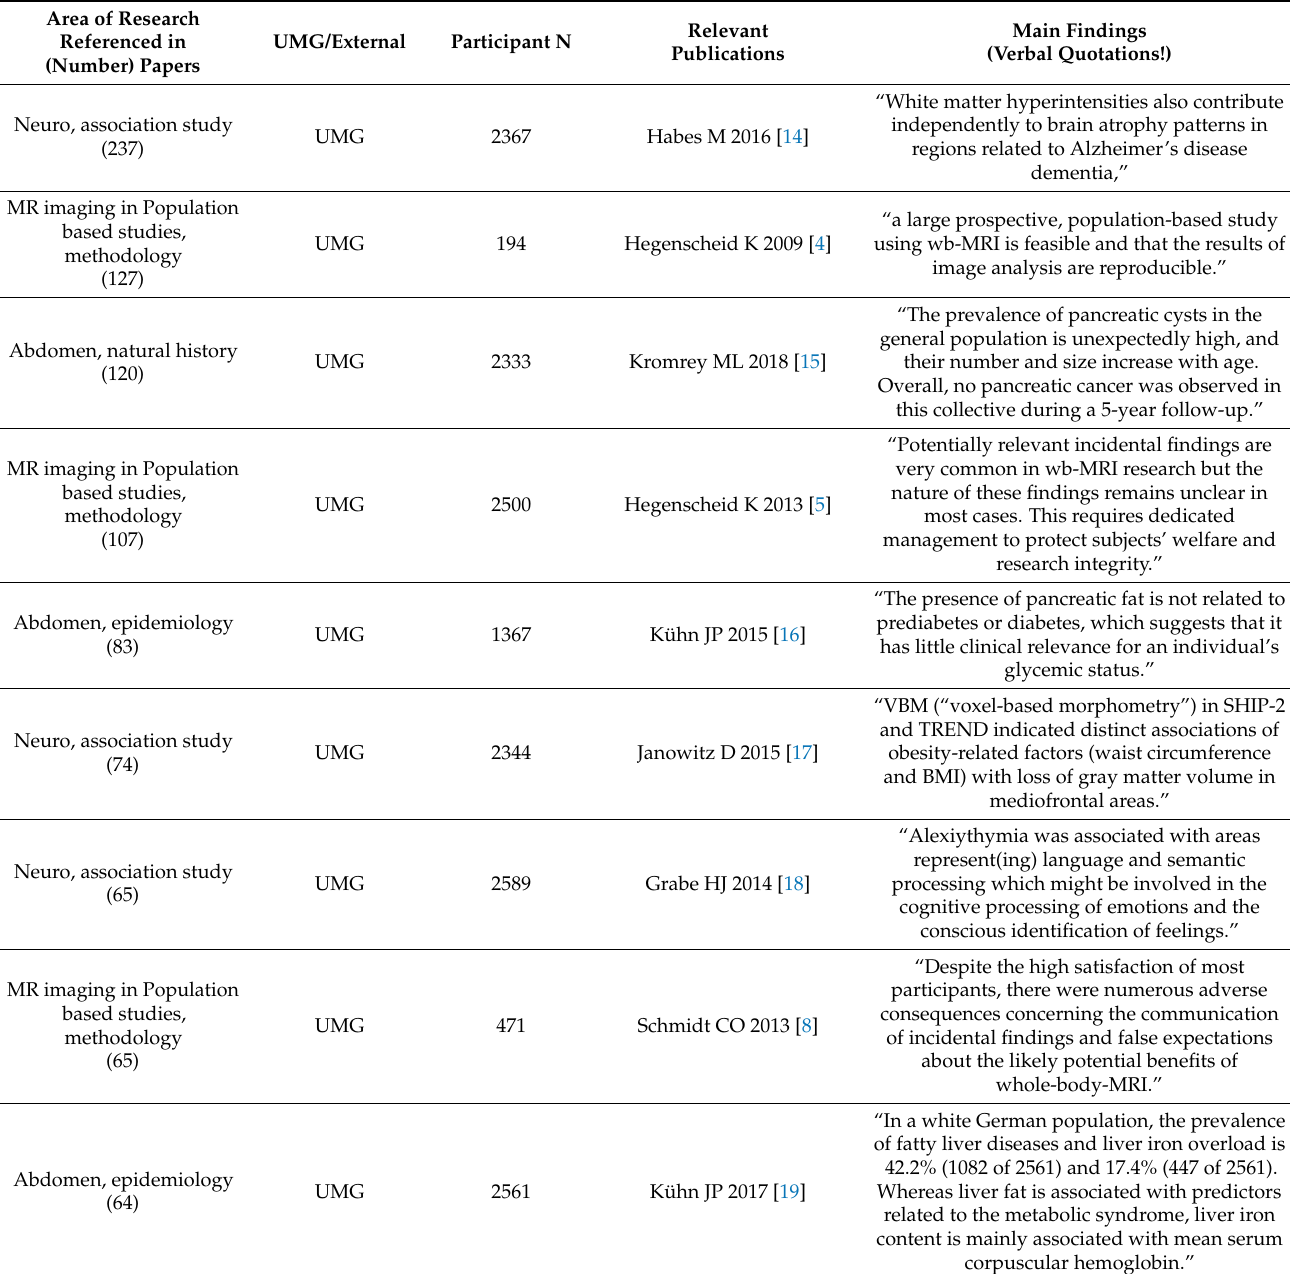
Table 1. Papers from the SHIP-MR imaging study that were referenced more than 50